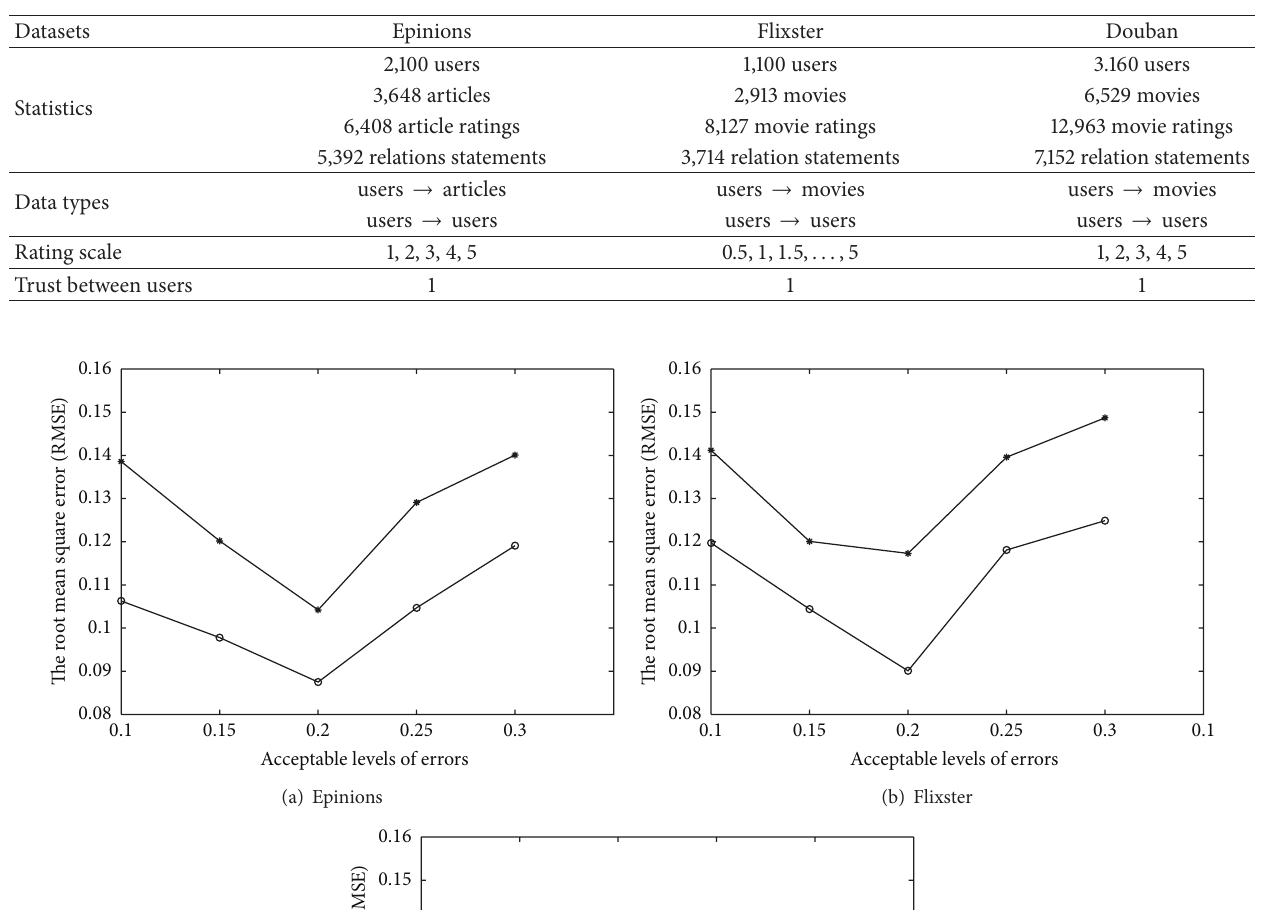
Table 1: Statistical information about the three real datasets.